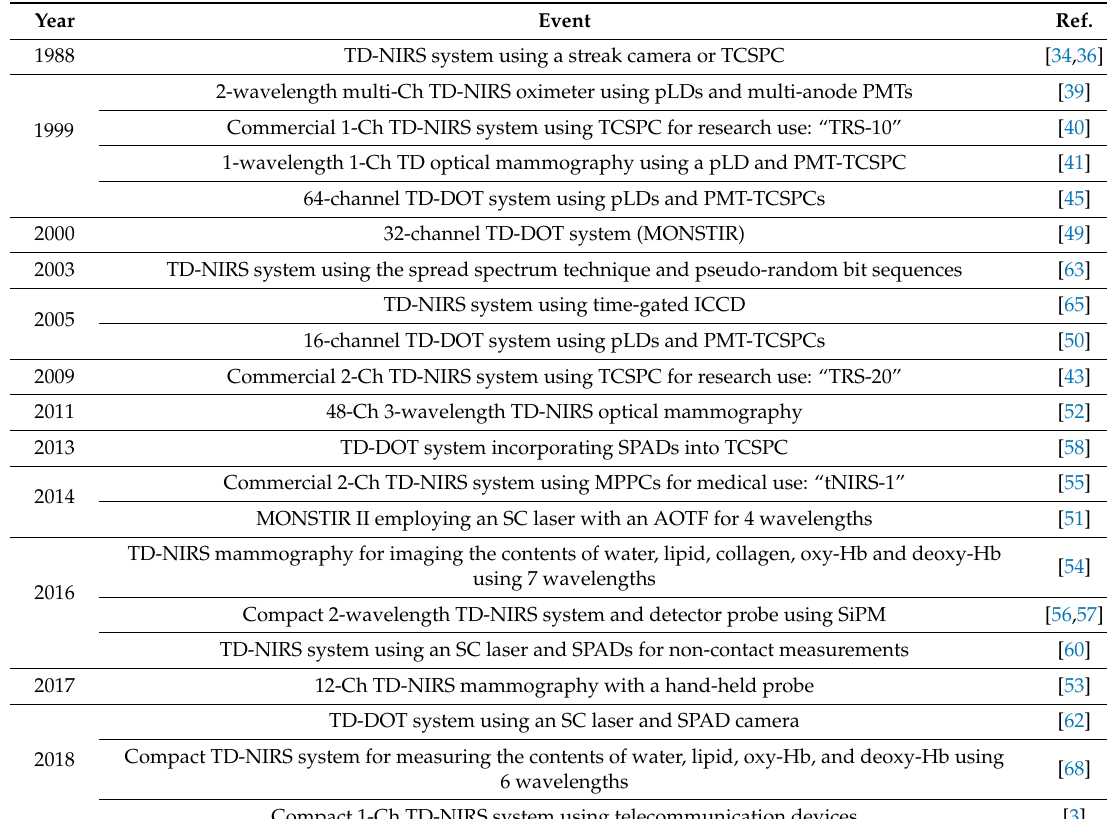
Table 1. Chronology of major events in instruments of TD-NIRS (Abbreviations: “Ch” for channel and “pLD” for pulsed laser diode).